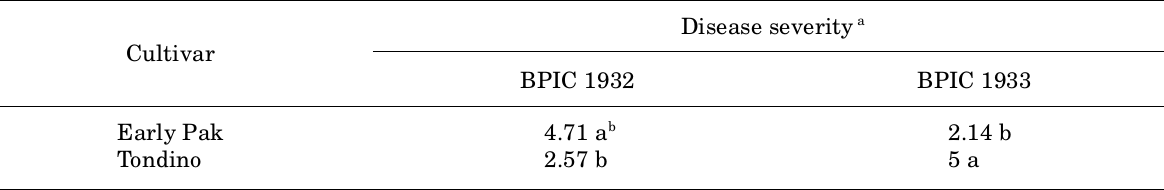
Table 3. Disease severity recorded on two tomato cultivars inoculated with Phytophthora nicotianae